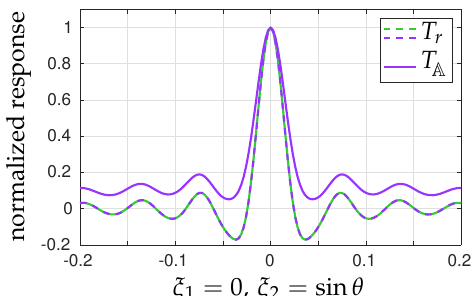
Figure 13. Cuts along the ξ 2 axis of the retrieved brightness temperature maps T r ( ξ ) (dashed lines) with the SAI (green) and DBF (purple) paradigms when the scene under observation T ( ξ ) is reduced to a single hot-spot in the boresight direction ξ = ( 0,0 ) . In both cases, the FWHM of the normalized response is about 0.0278 rad. Also shown on the graph is the same cut of the antenna temperature map T A ( ξ (cid:48) ) (solid line), the FWHM of the main beam is here about 0.0355